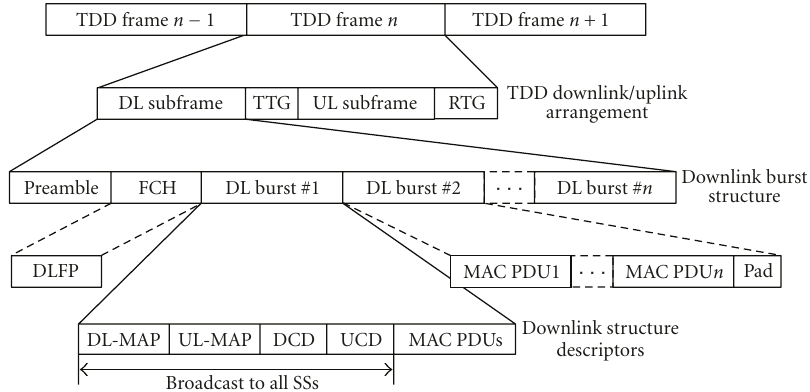
Figure 11: Fixed WiMAX/TDD frame structure and burst